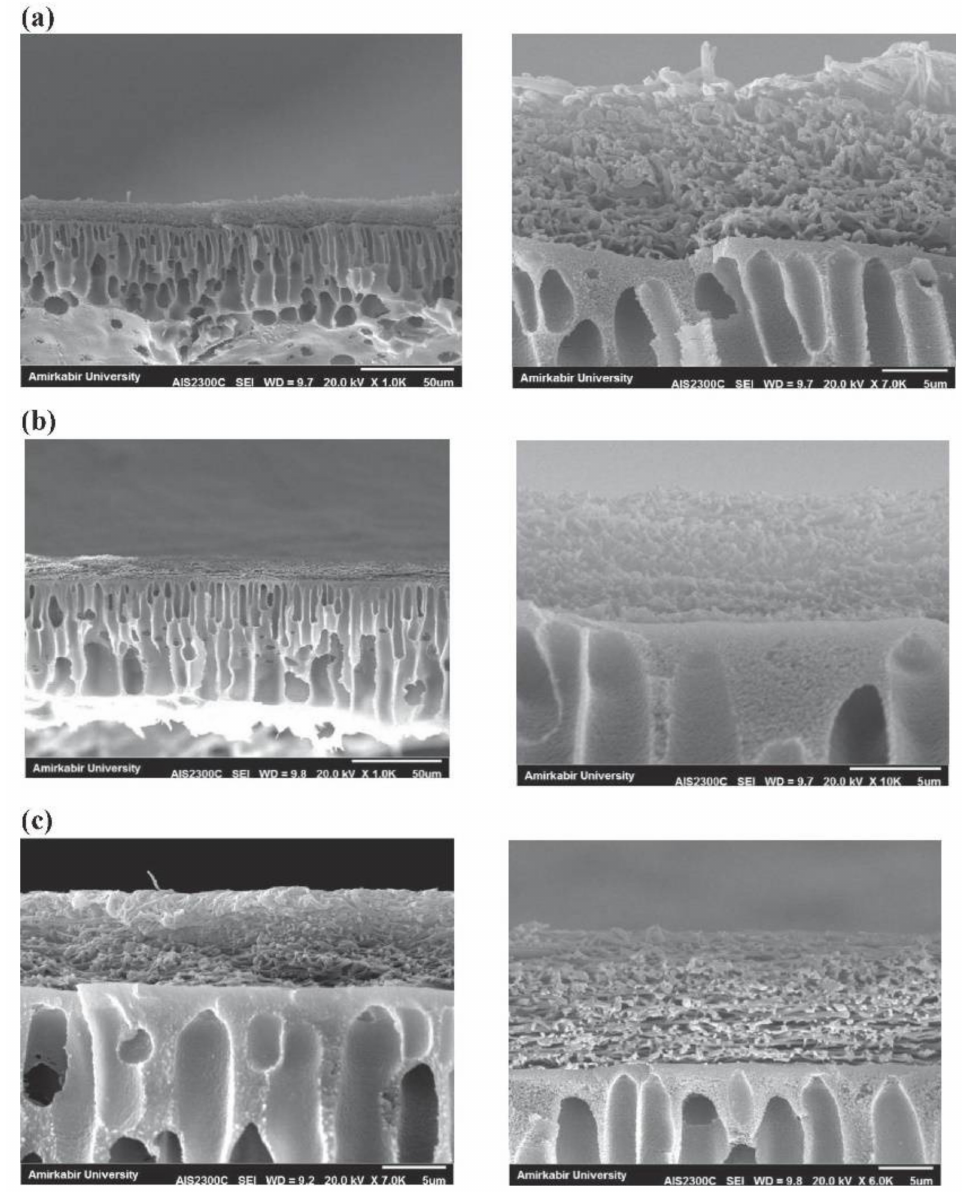
Figure 6. Cross-section images of ( a ) PES/PVA/chitosan, ( b ) PES/PVA/chitosan/A-Fe3O4-2 and ( c ) crosslinked PES/PVA/chitosan/A-Fe3O4-2 nanofibrous membranes. Reprinted with permission by